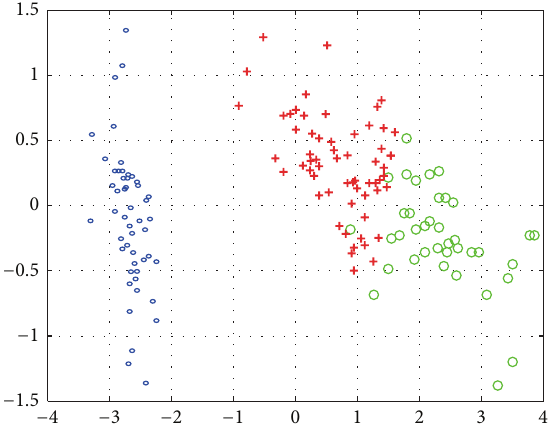
Figure 8: Clustering results obtained by ISODATA and KMRIC.